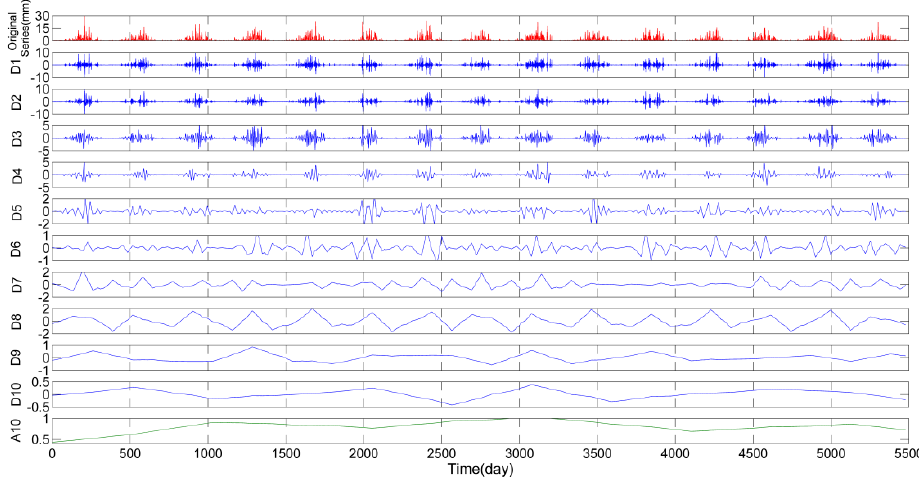
Figure 3. Results of discrete wavelet decomposition of precipitation series under each level.